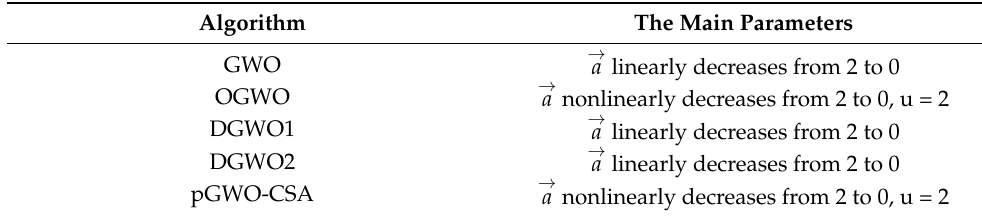
Table 5. Main parameters of the five